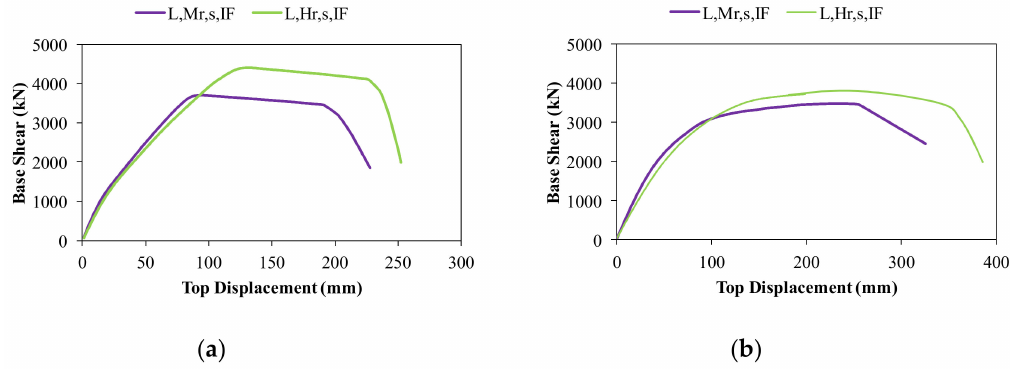
Figure 7. Pushover curves of the selected L-archetype buildings in ( a ) X-direction and ( b ) Y-direction. Figures 8–10 show the maximum inter story drift profiles (calculated as average between the two principal directions) at the reference limit states (i.e., ZL, OP, and DC) for the H-, M-, and L-archetype buildings,